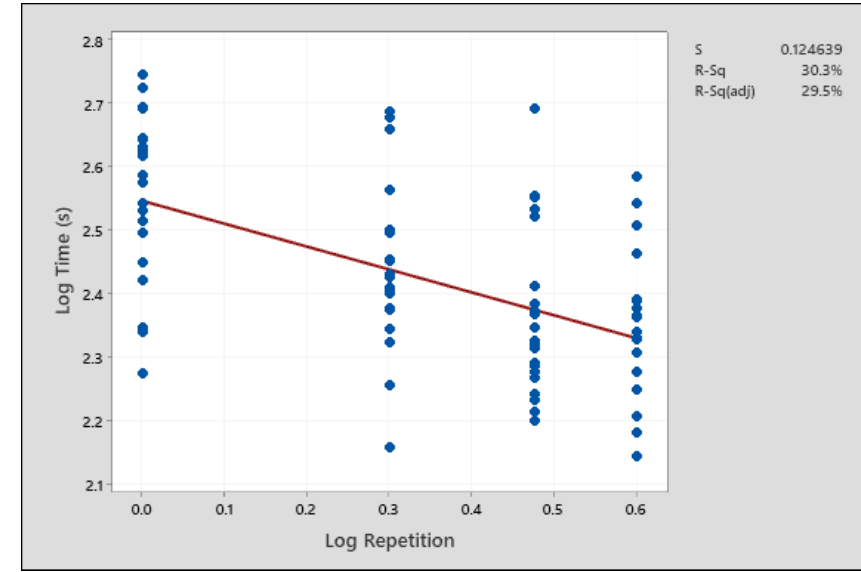
Figure 5 Linear regression fit with equation log T = 2.547 − 0.3597 log R .